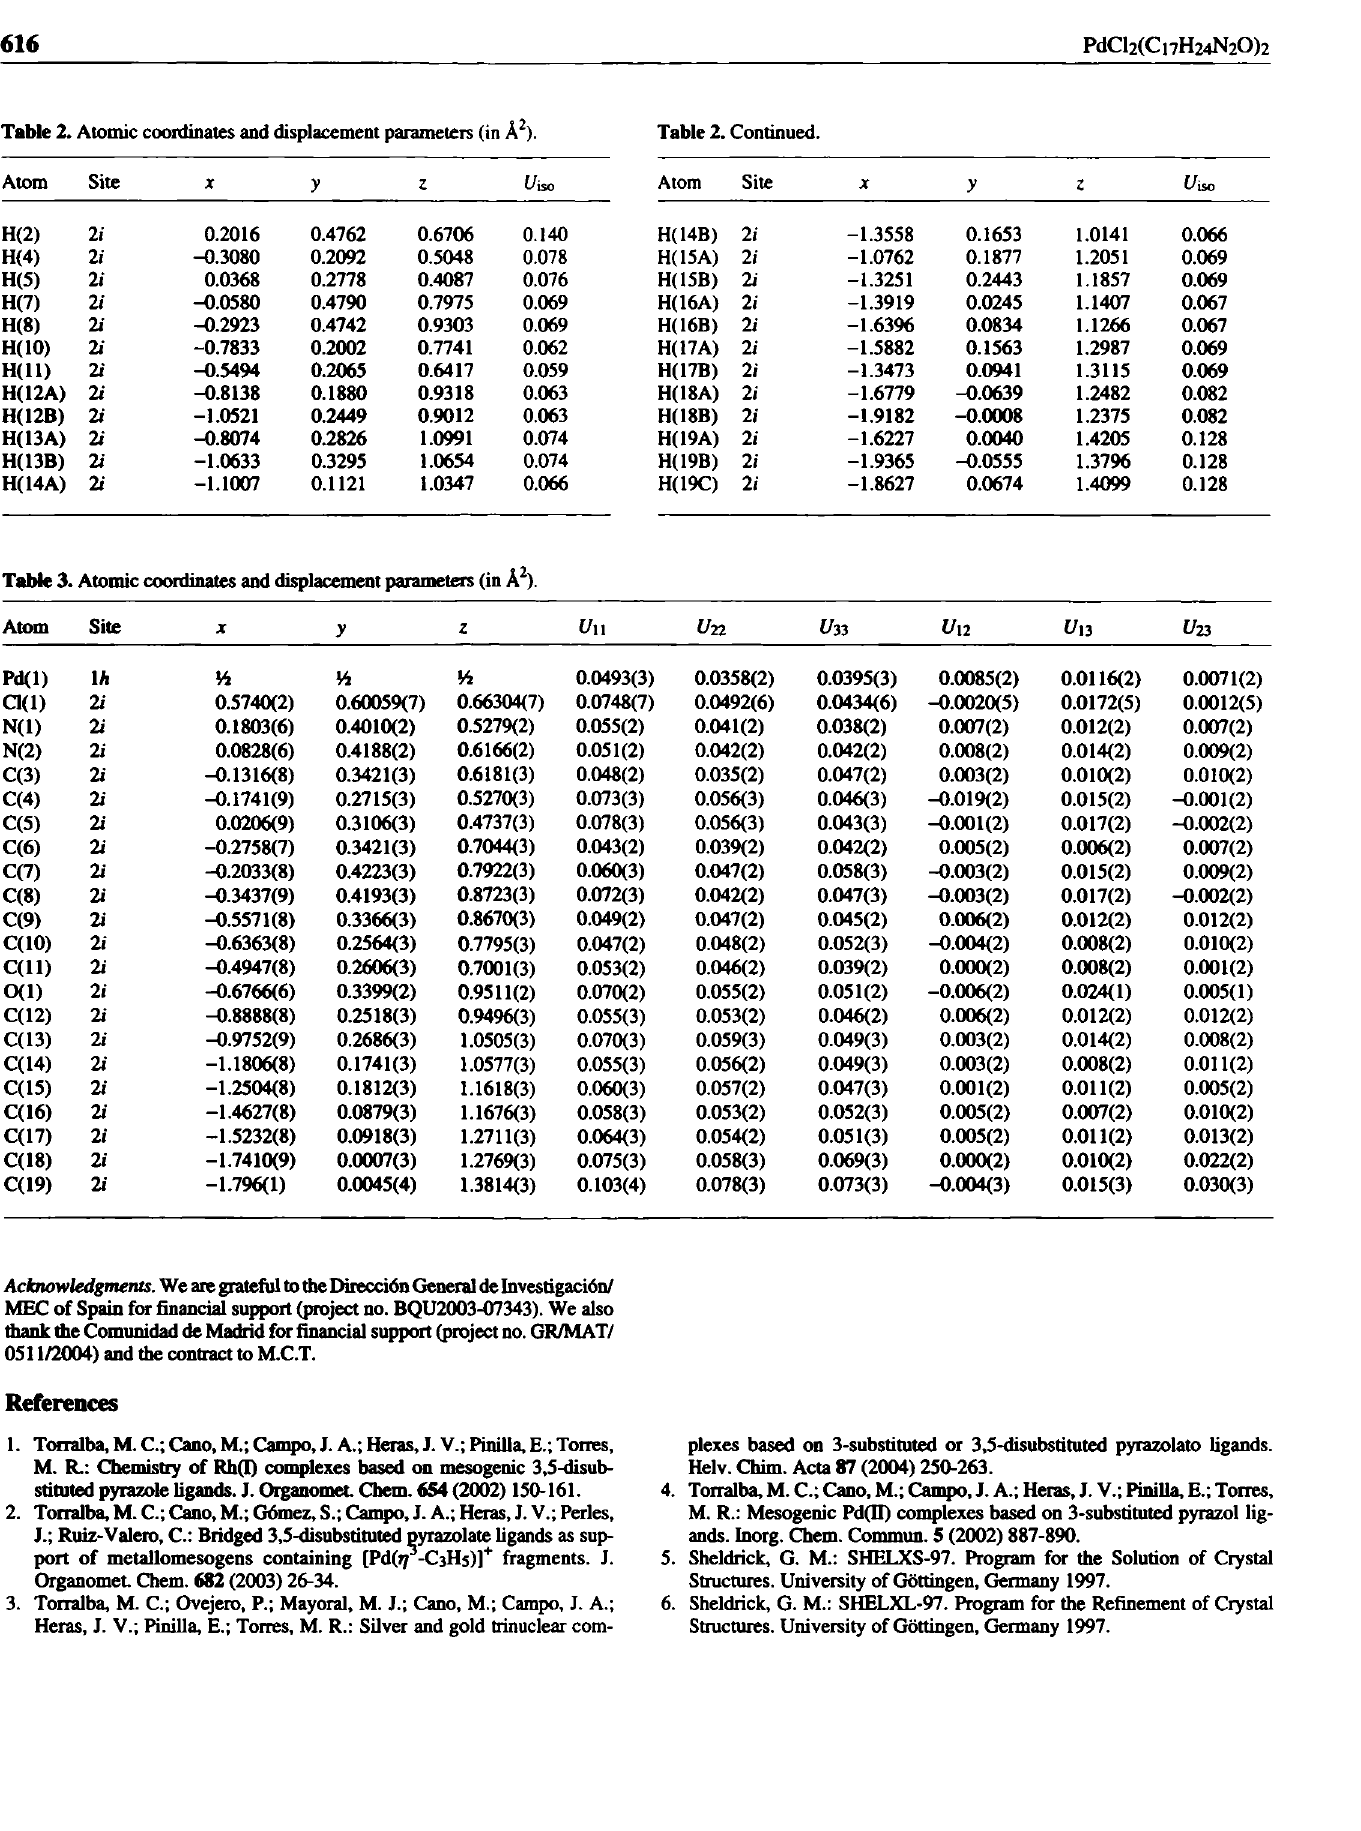
Table 2. Atomic coordinates and displacement parameters (in A 2 ). Table 2. Continued.